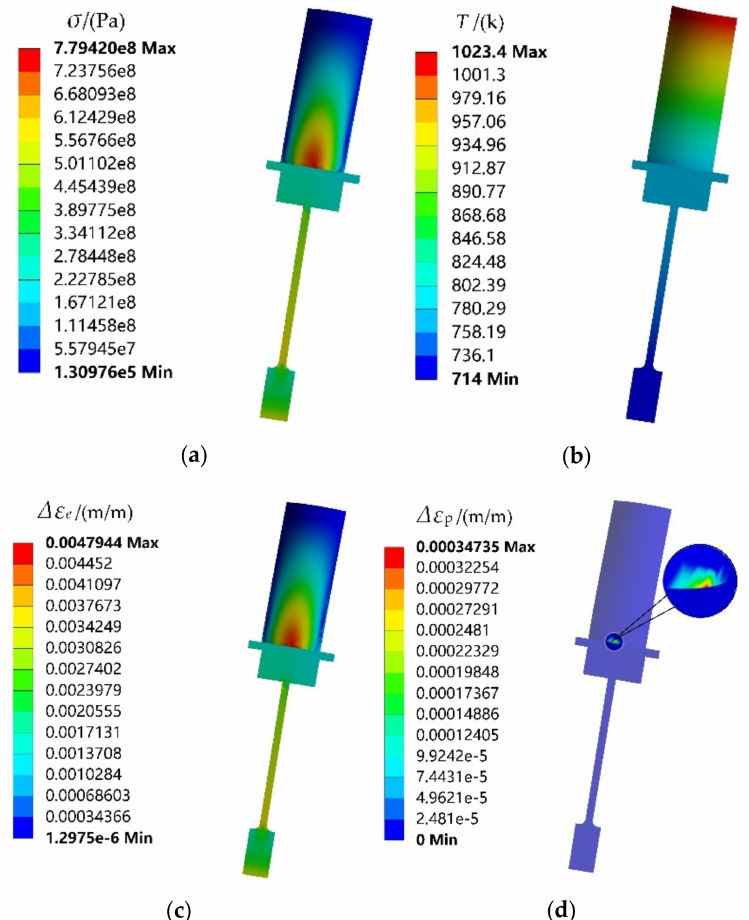
Figure 7. Nephogram of the stress-strain and temperature for turbine rotor: ( a ) stress, ( b ) temperature, ( c ) elastic strain range, ( d ) plastic strain